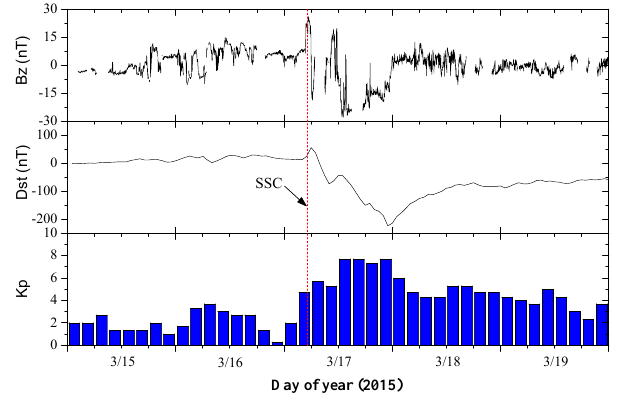
Figure 2. Variations of geomagnetic conditions IMF B z